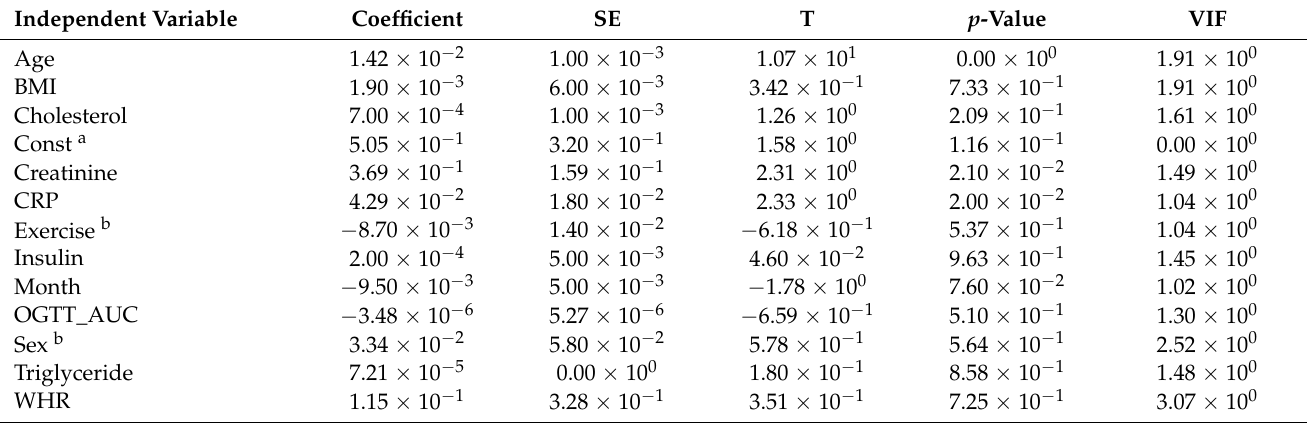
Table 3. Multiple linear regression analysis for studying the relationship between SAF value with phenotypic factors. VIF presents the multicollinearity indicator of corresponding variables. Significant factors ( p ≤ 5.00 × 10 − 2 ) are indicated by bold letters. SE stands for standard error. T-value is abbreviated as